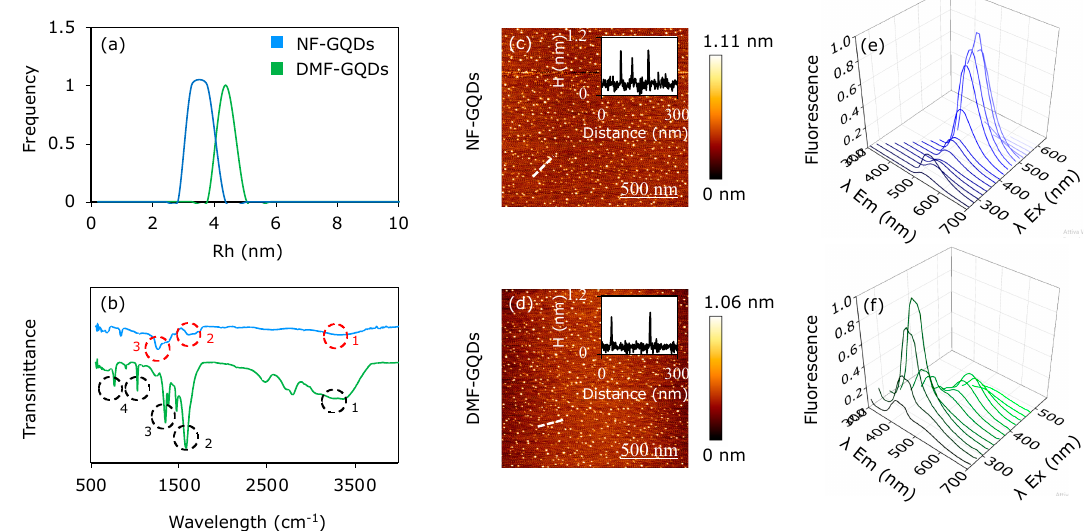
Figure 1. Characterization of graphene quantum dots (GQDs). Dynamic light scattering (DLS) of non-functionalized GQDs (NF-GQDs) and dimethylformamide-functionalized GQDs (DMF-GQDs ( a ). Fourier transform infrared spectroscopy (FTIR) spectra of NF-GQDs and DMF-GQDs ( b ). Atomic force microscopy imaging (AFM) imaging of NF-GQDs ( c ) and DMF-GQDs ( d ), with relative line profile (insets). Dashed lines show the image regions corresponding to the line profiles in the insets. Optical characterization by fluorescence emission spectra of NF-GQDs ( e ) and DMF-GQDs ( f ).